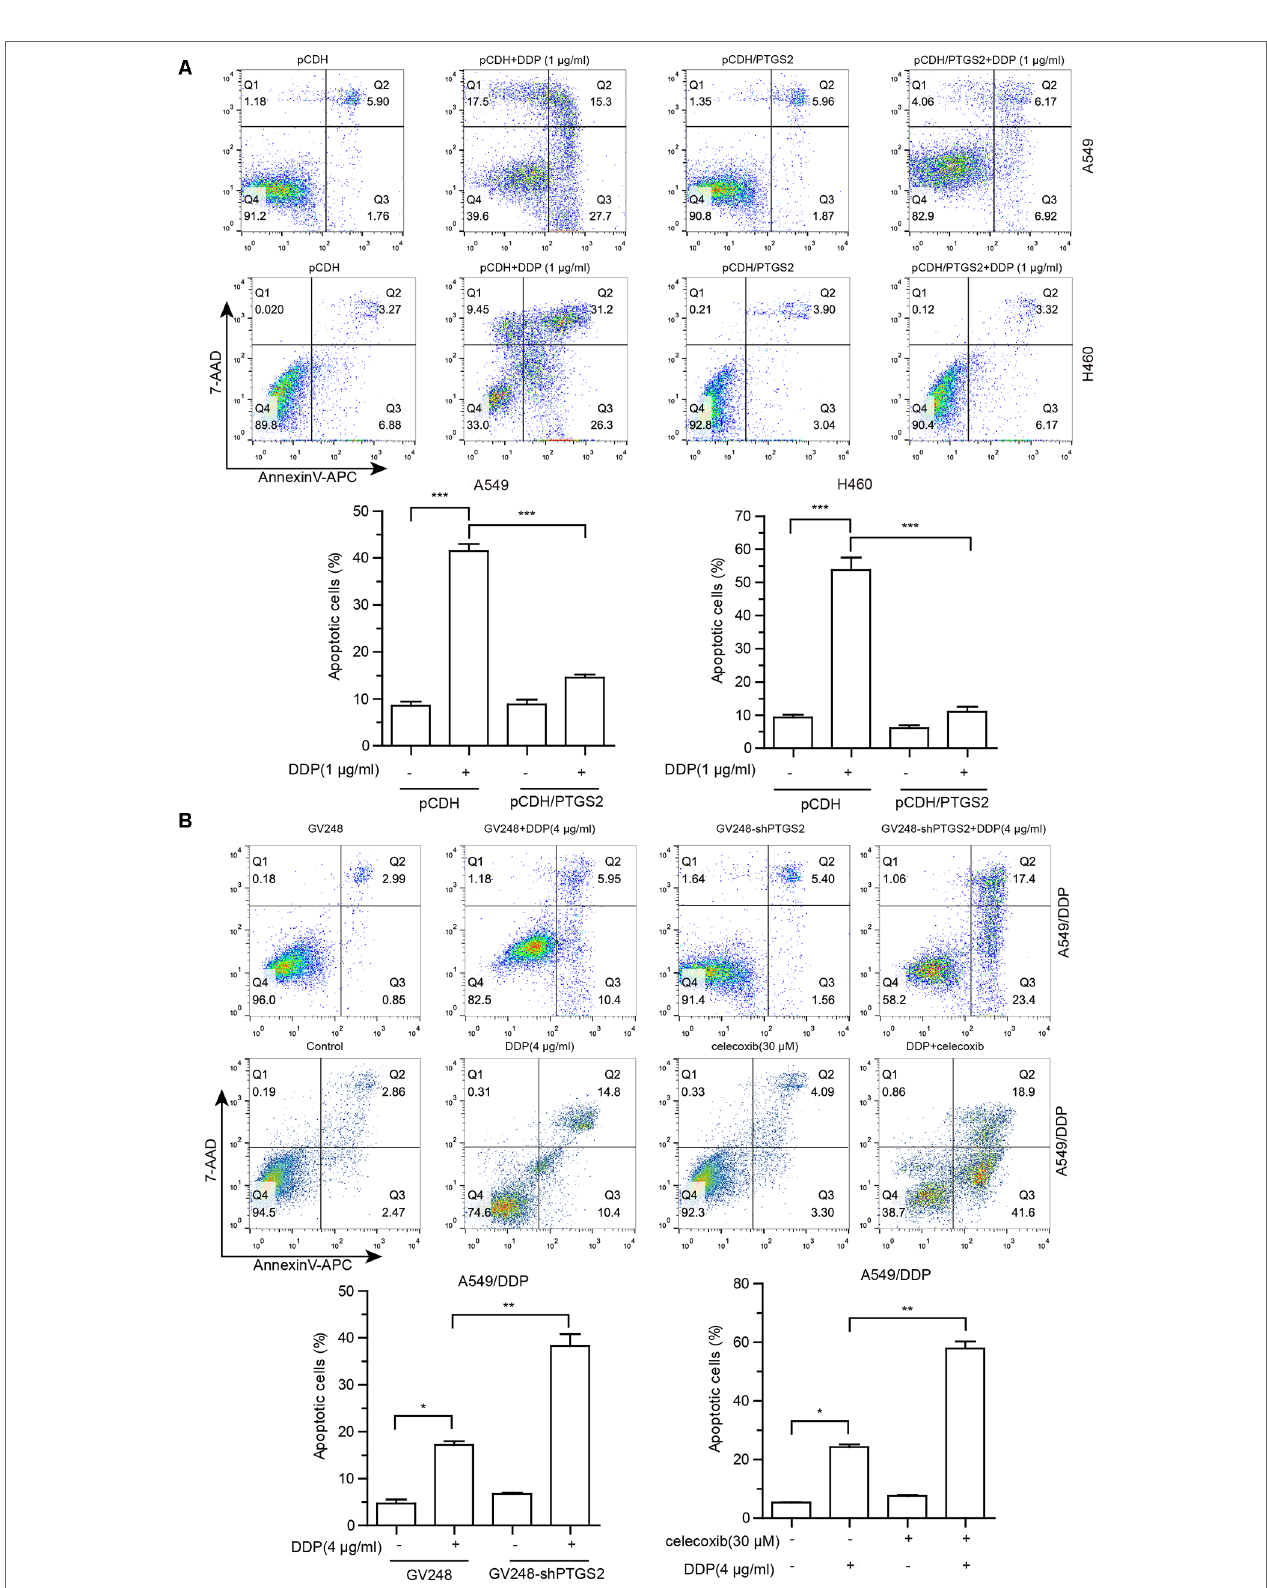
FIGURE 2 | The effects of PTGS2 on cisplatin-induced apoptosis. (A and B) Cells were plated at a density of 2.5 × 10 5 /well in 12-well plates. After 12 h, cells were treated with 1 μg/ml or 4 μg/ml cisplatin for 48 h. For groups of co-treatment, cells were pre-treated with celecoxib for 6 h prior to the treatment of cisplatin. Cell apoptosis was quantified by annexin-V/APC and 7-AAD staining. * P < 0.05; ** P < 0.01; *** P <